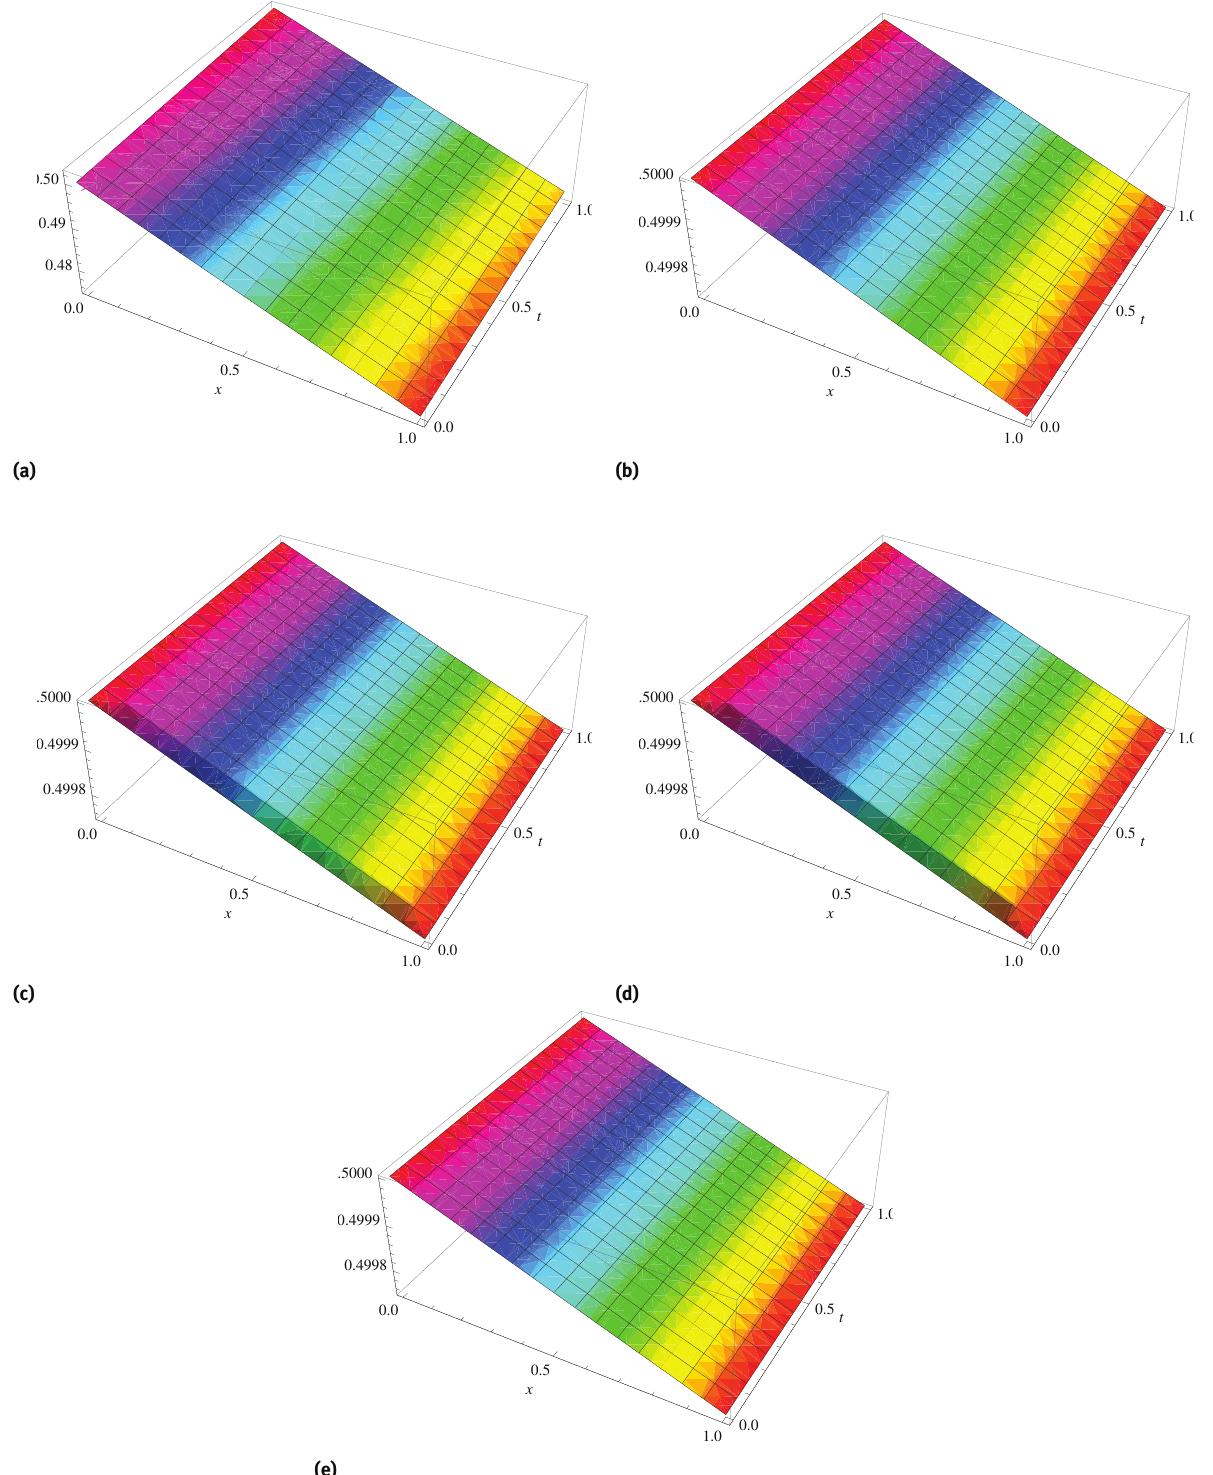
Fig. 6: Surface shows the 3rd order approximate solution of the time- fractional B-F equation: (a) u 3 ( x , t ) when α = 1 , (b) u 3 ( x , t ) when α = 0.75 , (c) u 3 ( x , t ) when α = 0.5 , (d) u 3 ( x , t ) when α = 0.25 , (e) exact solution u ( x , t ) when α = 1